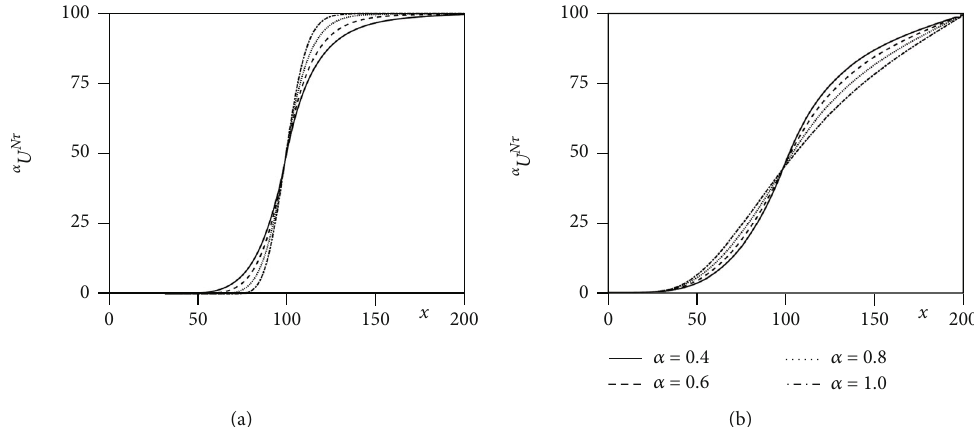
Figure 3: Numerical results for cash-or-nothing option for di ff erent fractional-orders α = 0 : 4,0 : 6,0 : 8 , and 1 : 0 with maturity times (a) T = 0 : 1 and (b) T = 2 : 5 .